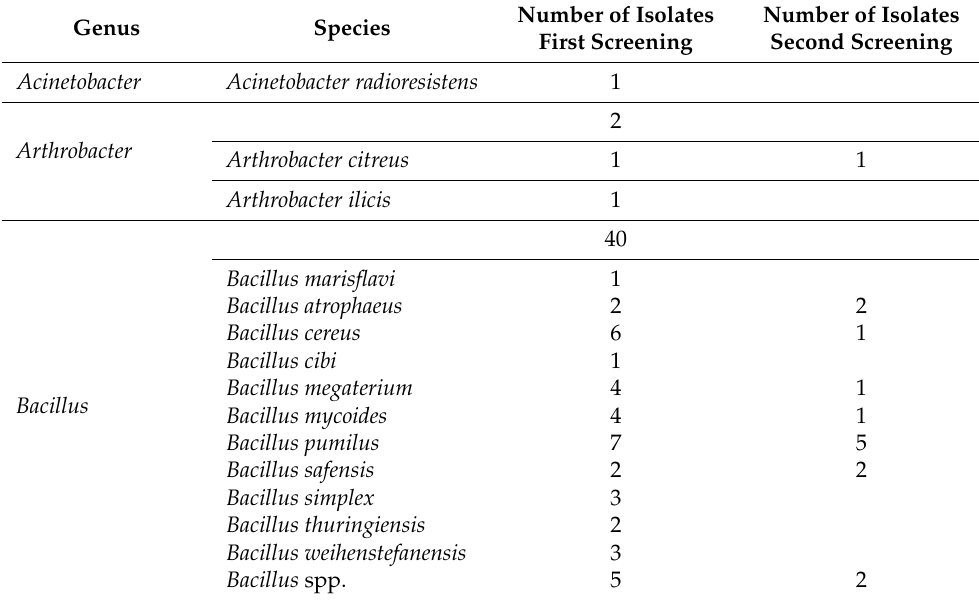
Table 1. Genus and species identification of the 132 potential antimicrobial-producing isolates obtained in the first screening and those 32 isolates verified in the second screening. Number of Isolates Number of Genus Species First Screening